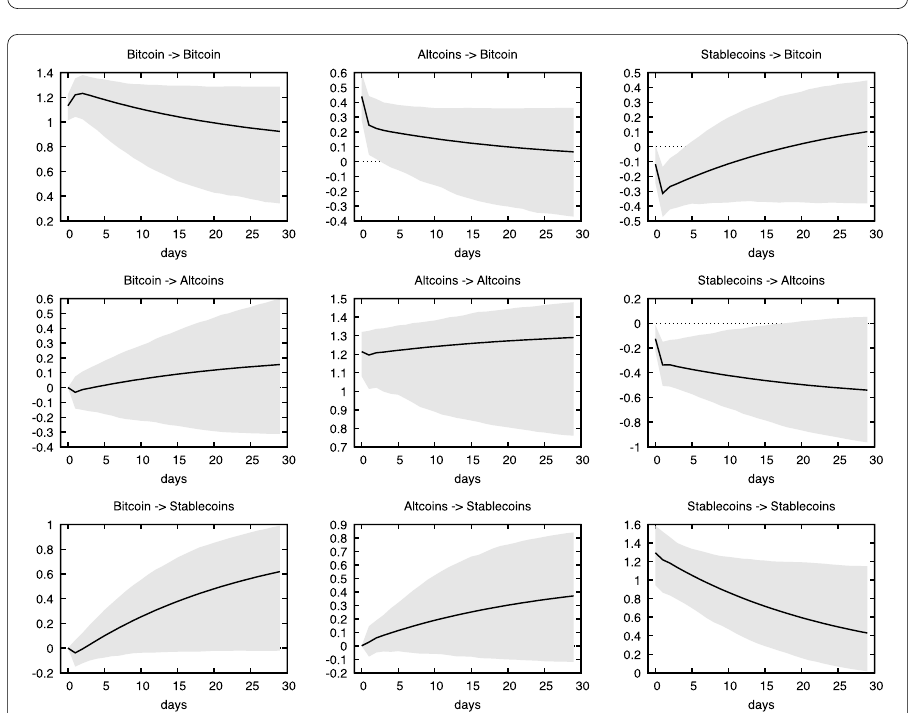
Fig. 6 Impulse-response functions of market capitalizations for 2017. Impulse response functions based on the cointegrated VAR with 1 lag and a restricted trend are shown for the time horizon of 30 days ( x -axes), with a standard deviation of the given series as a unit of measurement. The rest of the notation holds from Fig.